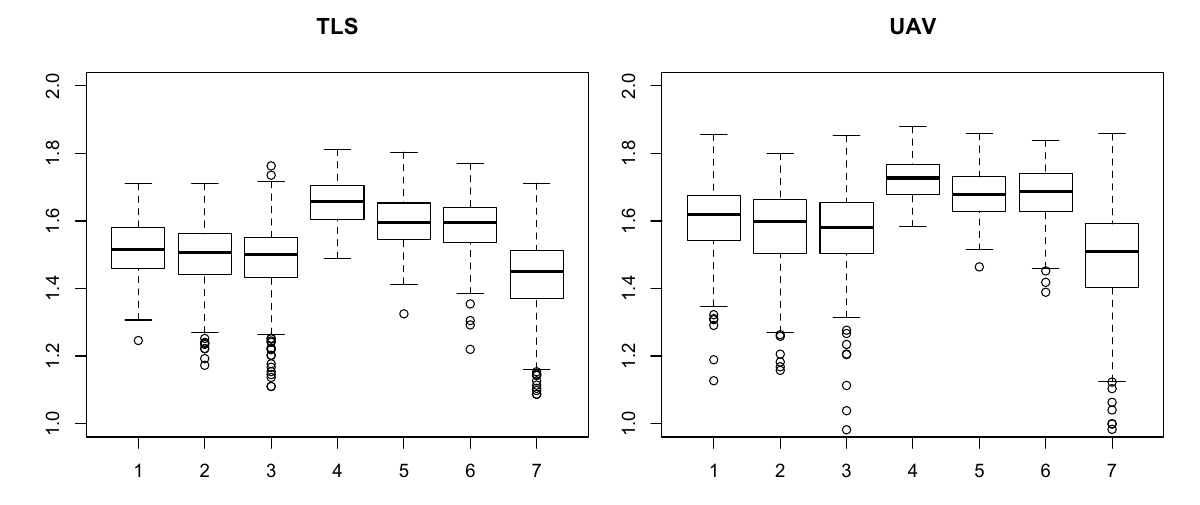
Figure 5. Boxplots of terrestrial laser scanning (TLS, left) and unmanned aerial vehicle (UAV, right) measured box dimension (D b ) values ( y -axis) within different thinning treatments ( x -axis). Treatment numbers are explained in Table 2.